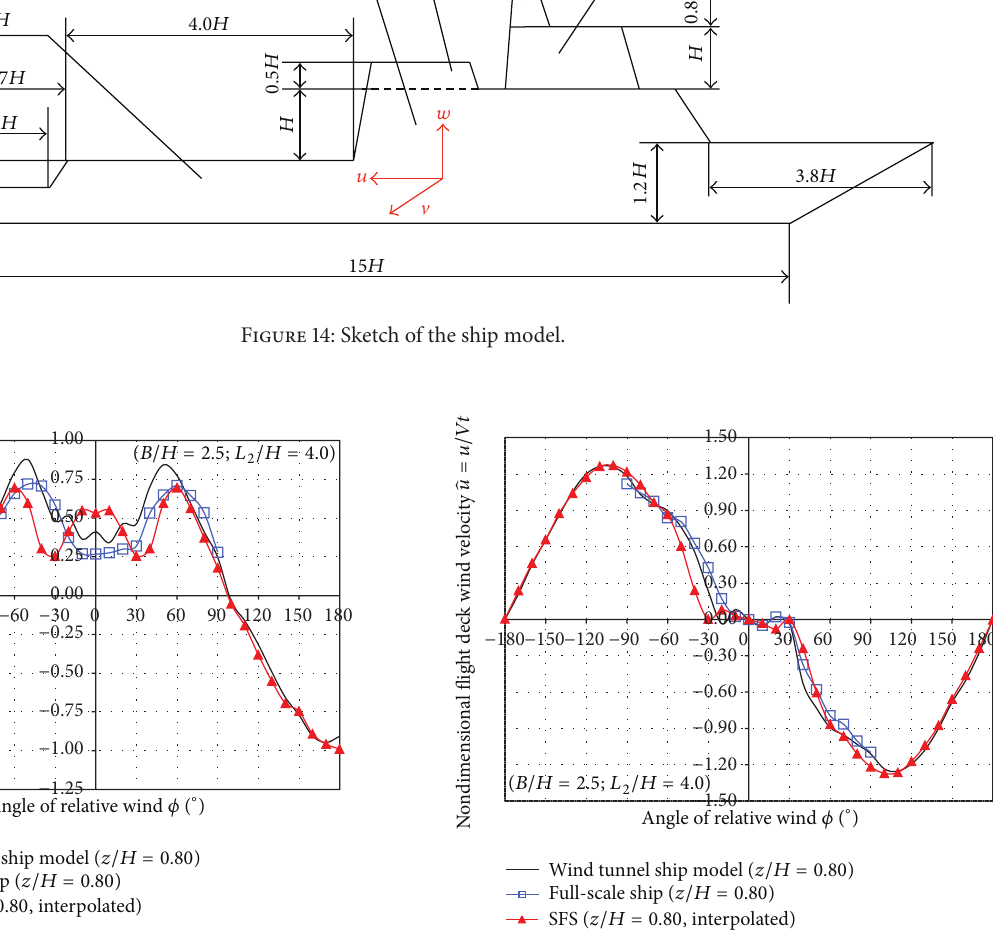
Figure 16: Comparison of the lateral nondimensional